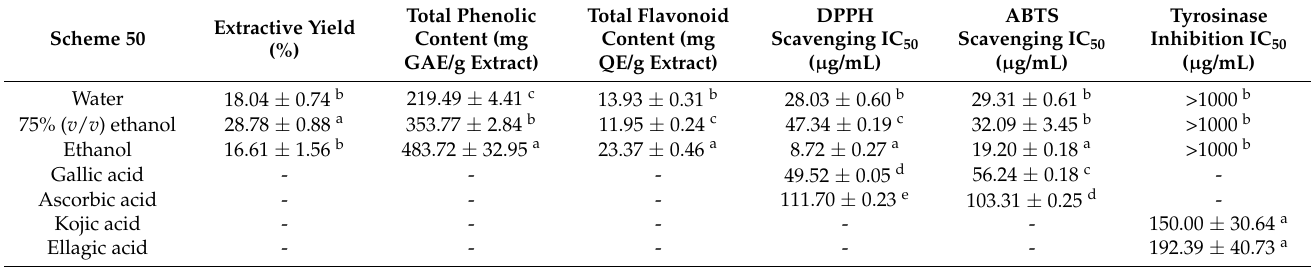
Table 1. Extractive yield, phenolic content, flavonoid content, and biological properties of Nephelium lappaceum